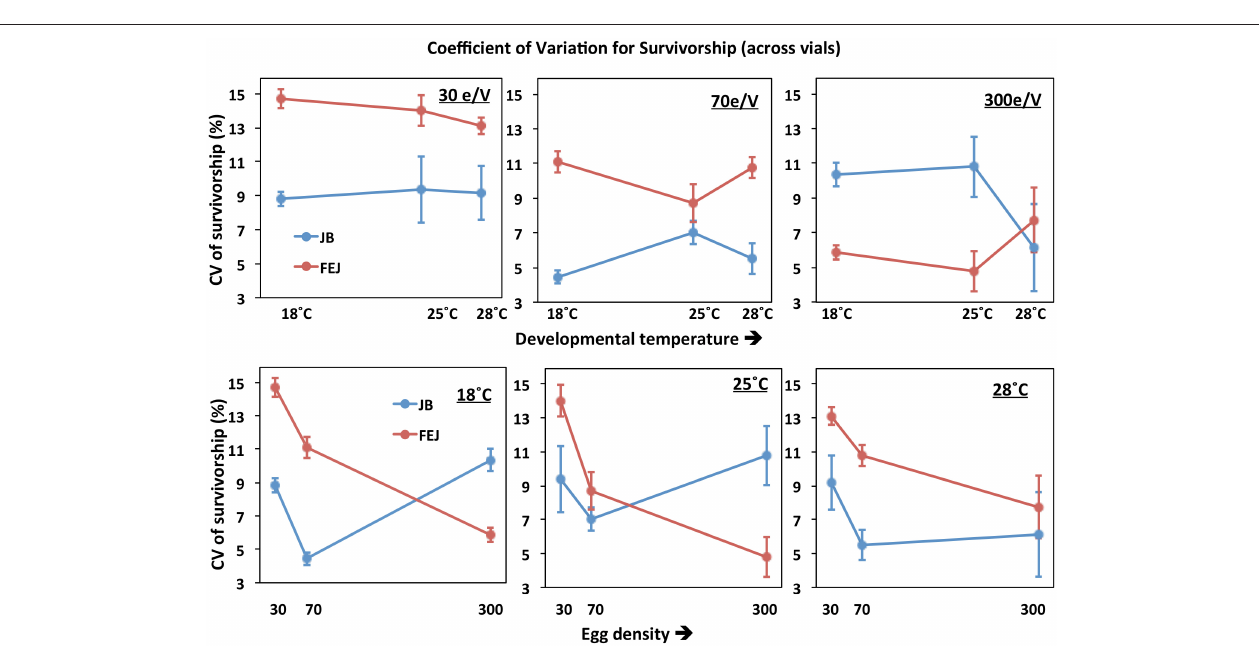
FIGURE 5 | Coefficient of variation (CV) of pre-adult survivorship of FEJ and JB populations across vials. The upper panel shows CV of the trait plotted across temperature for each treatment density (e/V = eggs per vial). The lower panel shows CV of the trait plotted across egg density for each treatment temperature. The error bars show 95% confidence intervals calculated from the variation among replicate populations in each combination of selection regime, temperature, and density. by larvae (Sang, 1956; Ashburner, 1989). It is possible that pre- slower feeders than JB larvae (Prasad et al., 2001), exhibit an Allee adult survivorship in the FEJ is more sensitive to across vial effect even at a density of 30 eggs per vial, whereas that density is microenvironment variation because the FEJ larvae, being much sufficiently high for JB larvae not to be exhibiting an Allee